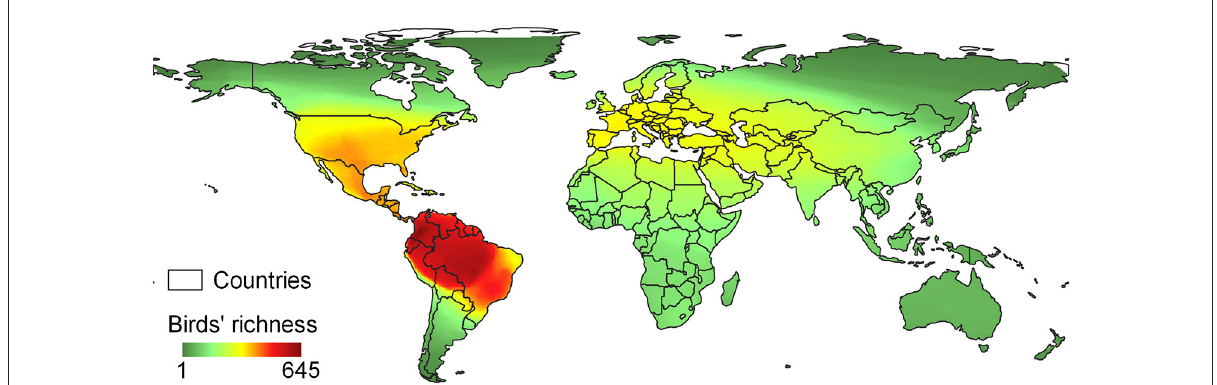
FIGURE2 Map of birds’ richness based on the distribution of the species included in our analysis among the eligible studies ( n = 75).